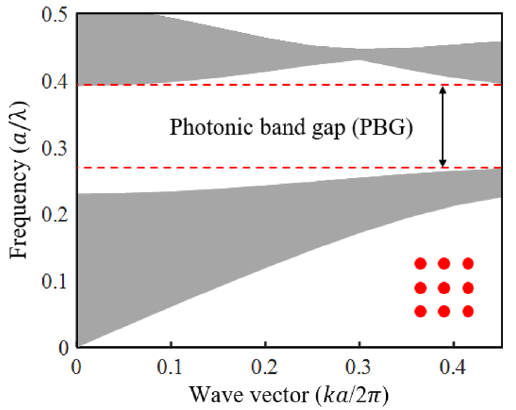
Figure 6. The band structure of PhC used in the proposed hybrid P-PhC RI sensor.